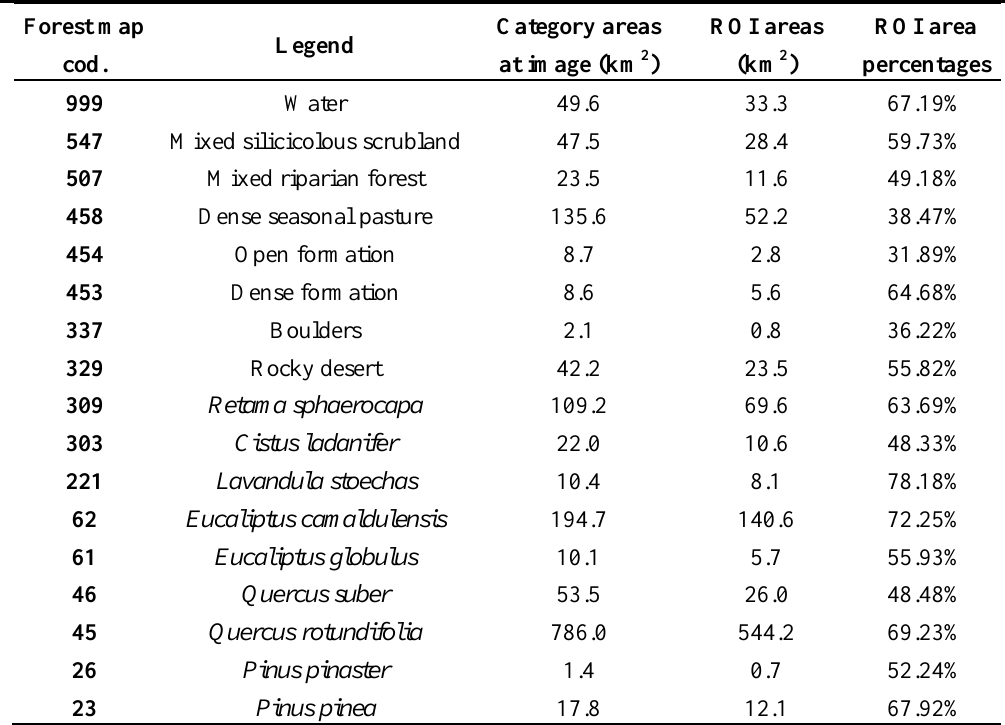
Table 3. Regions of interest (ROI) used in the